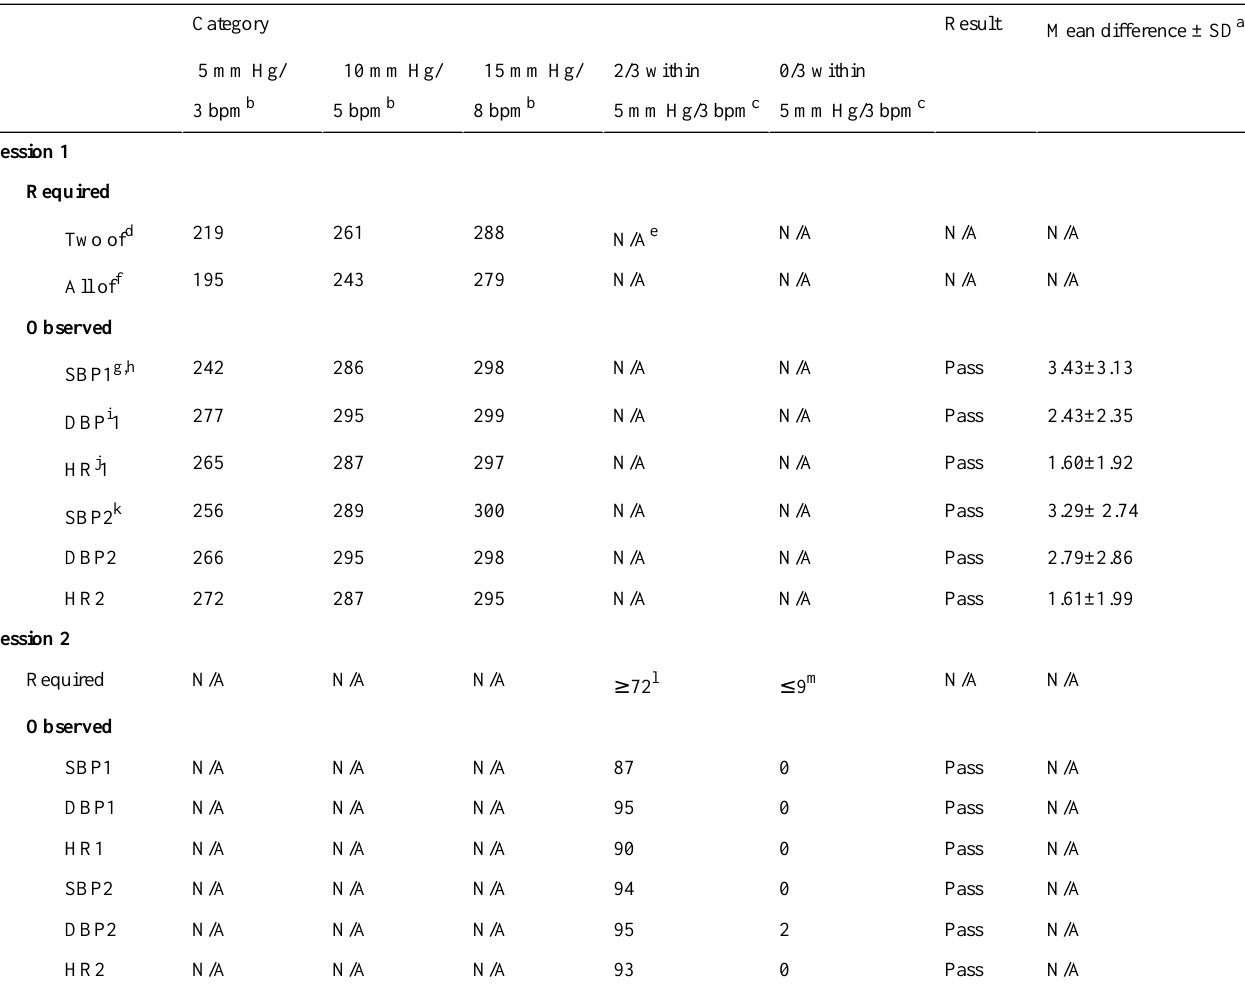
Table 3. shows the validity results for the QardioArm, with the Omron M3 as the criterion. The QardioArm passed both sessions of the ESH validation process for SBP, DBP, and